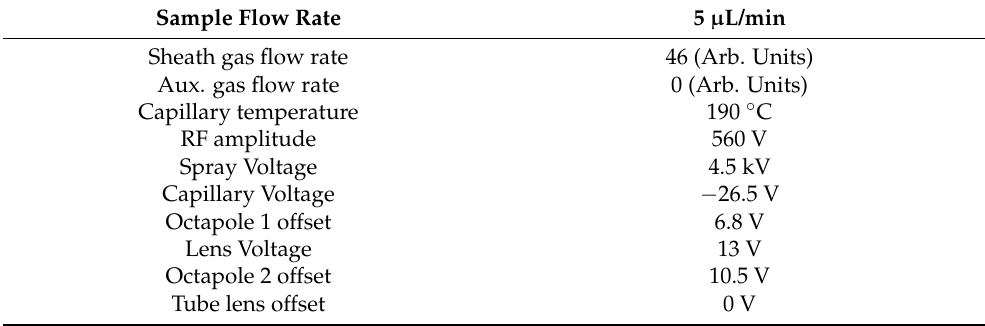
Table 4. Machine settings employed for the Thermo-Fisher LCQ mass spectrometer.